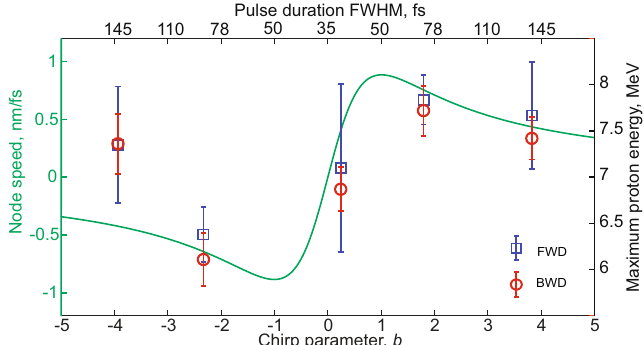
Figure 3. Velocity of the nodes of the SW, as a function of the chirp in the same range of the experiment (green curve), together with the proton energies detected from the 10 nm-thick